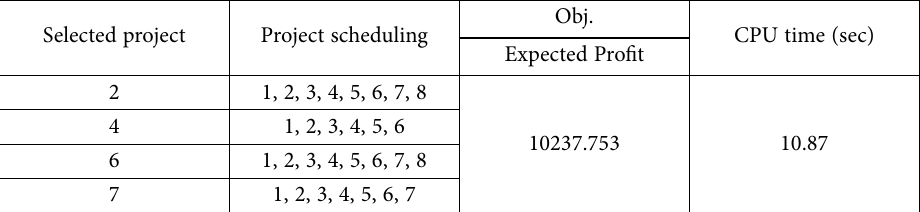
Table 3. The result of the second scenario Selected